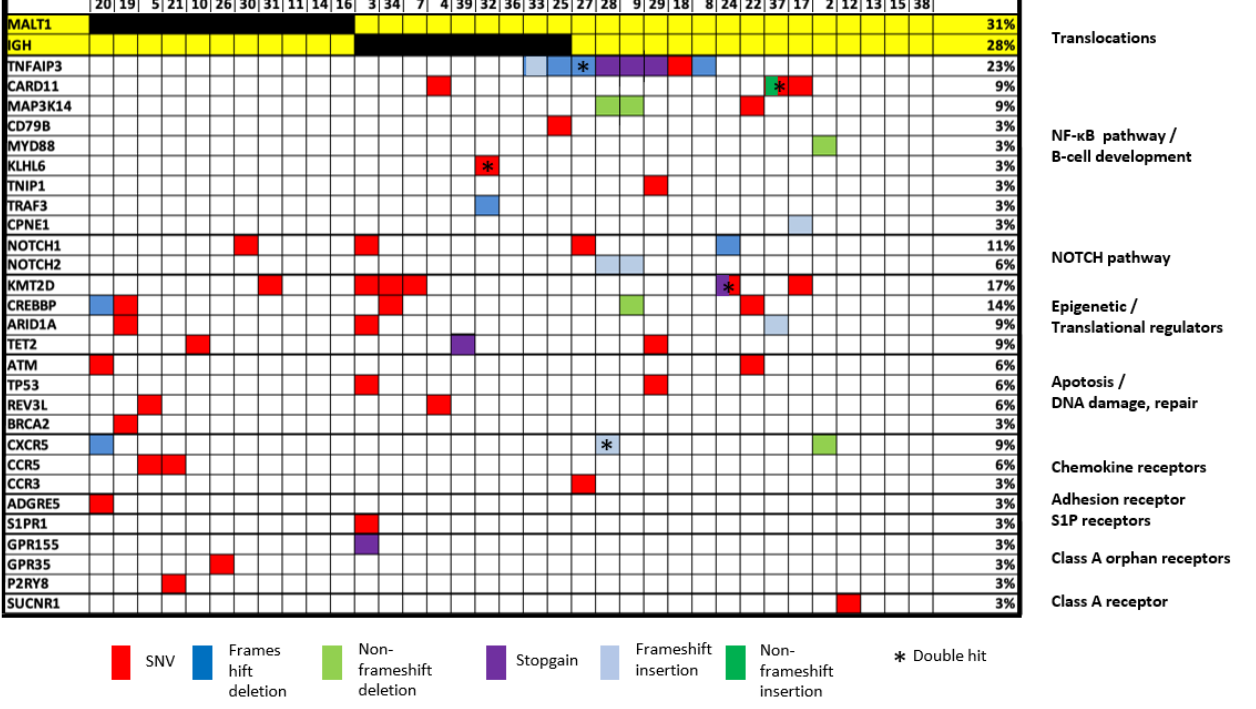
Figure 3. Heatmap illustration of genetic changes according to molecular pathways. Only cases successfully investigated by targeted sequencing are included in this figure ( n = 35).